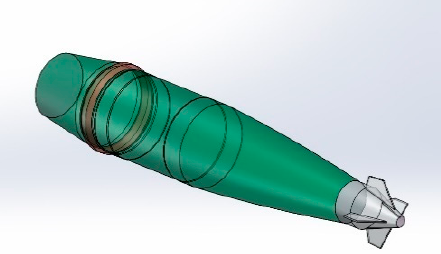
Figure 1. Schematic diagram of two-dimensional trajectory correction projectile.